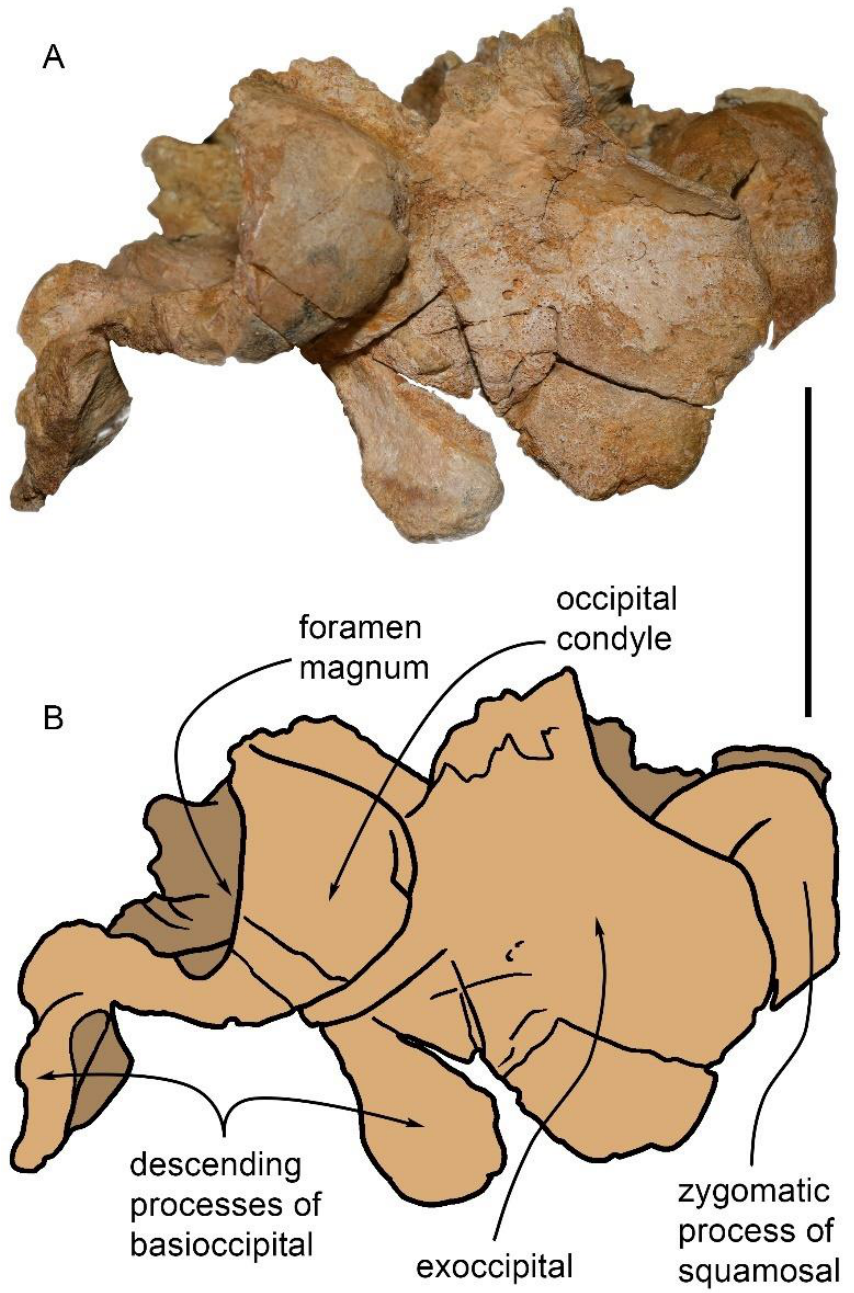
Figure 8. Partial skull MGPT-PU 13881/1 in posterior view. ( A ) Photographic representation. ( B ) Anatomical interpretation of ( A ). Scale bar equals 5 cm.